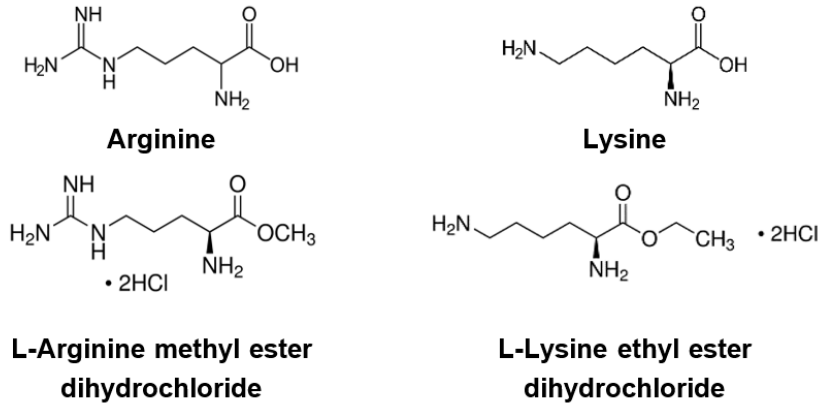
Figure 1. Chemical structure of the compounds.